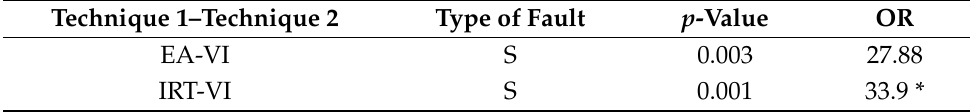
Table 9. p -value less than α and OR obtained by analyzing significant differences for each type of failure.